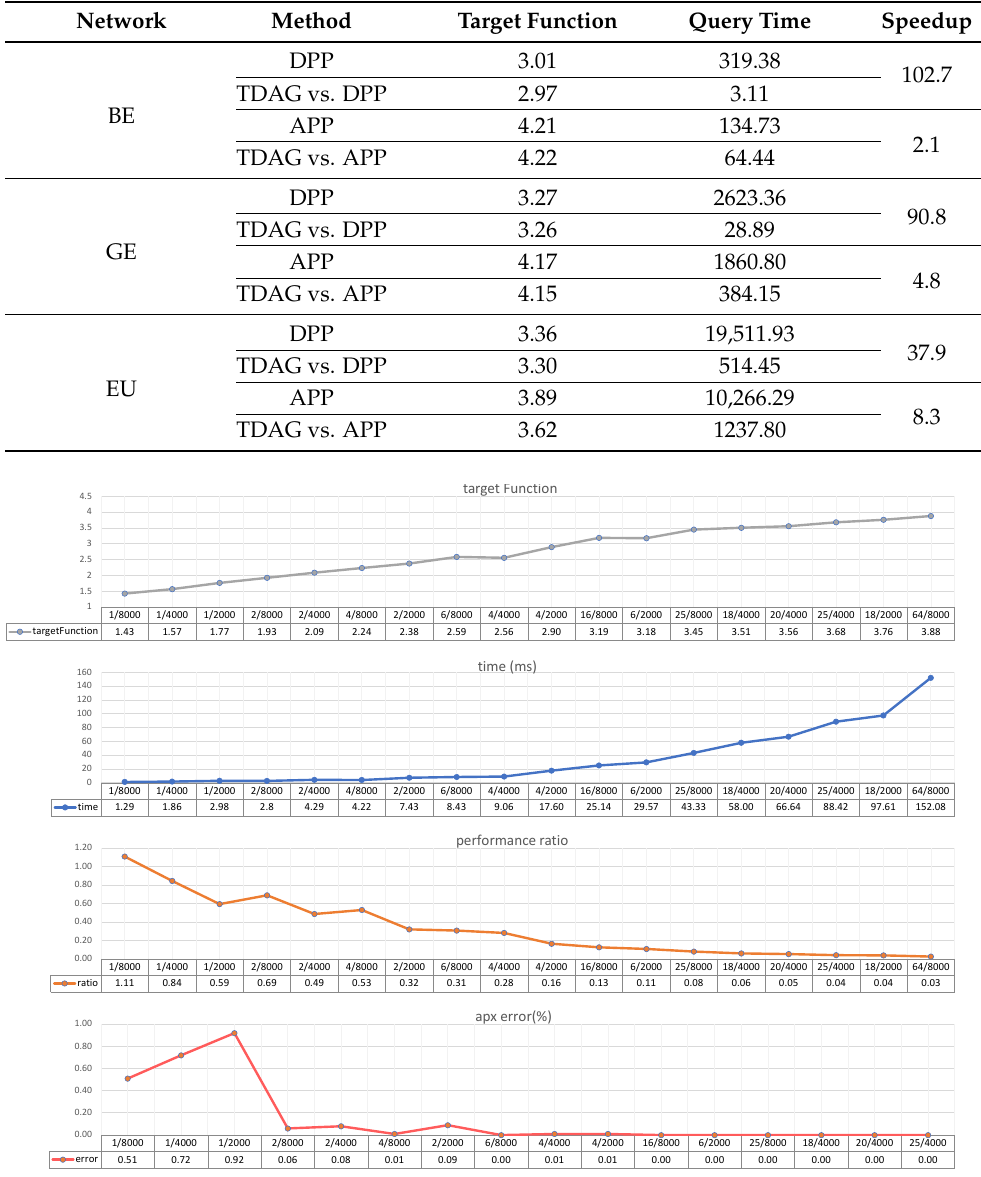
Table 2. Speedups of TDAG over DPP (with TDD) and APP (with A ∗ and free-flow lower-bounds).